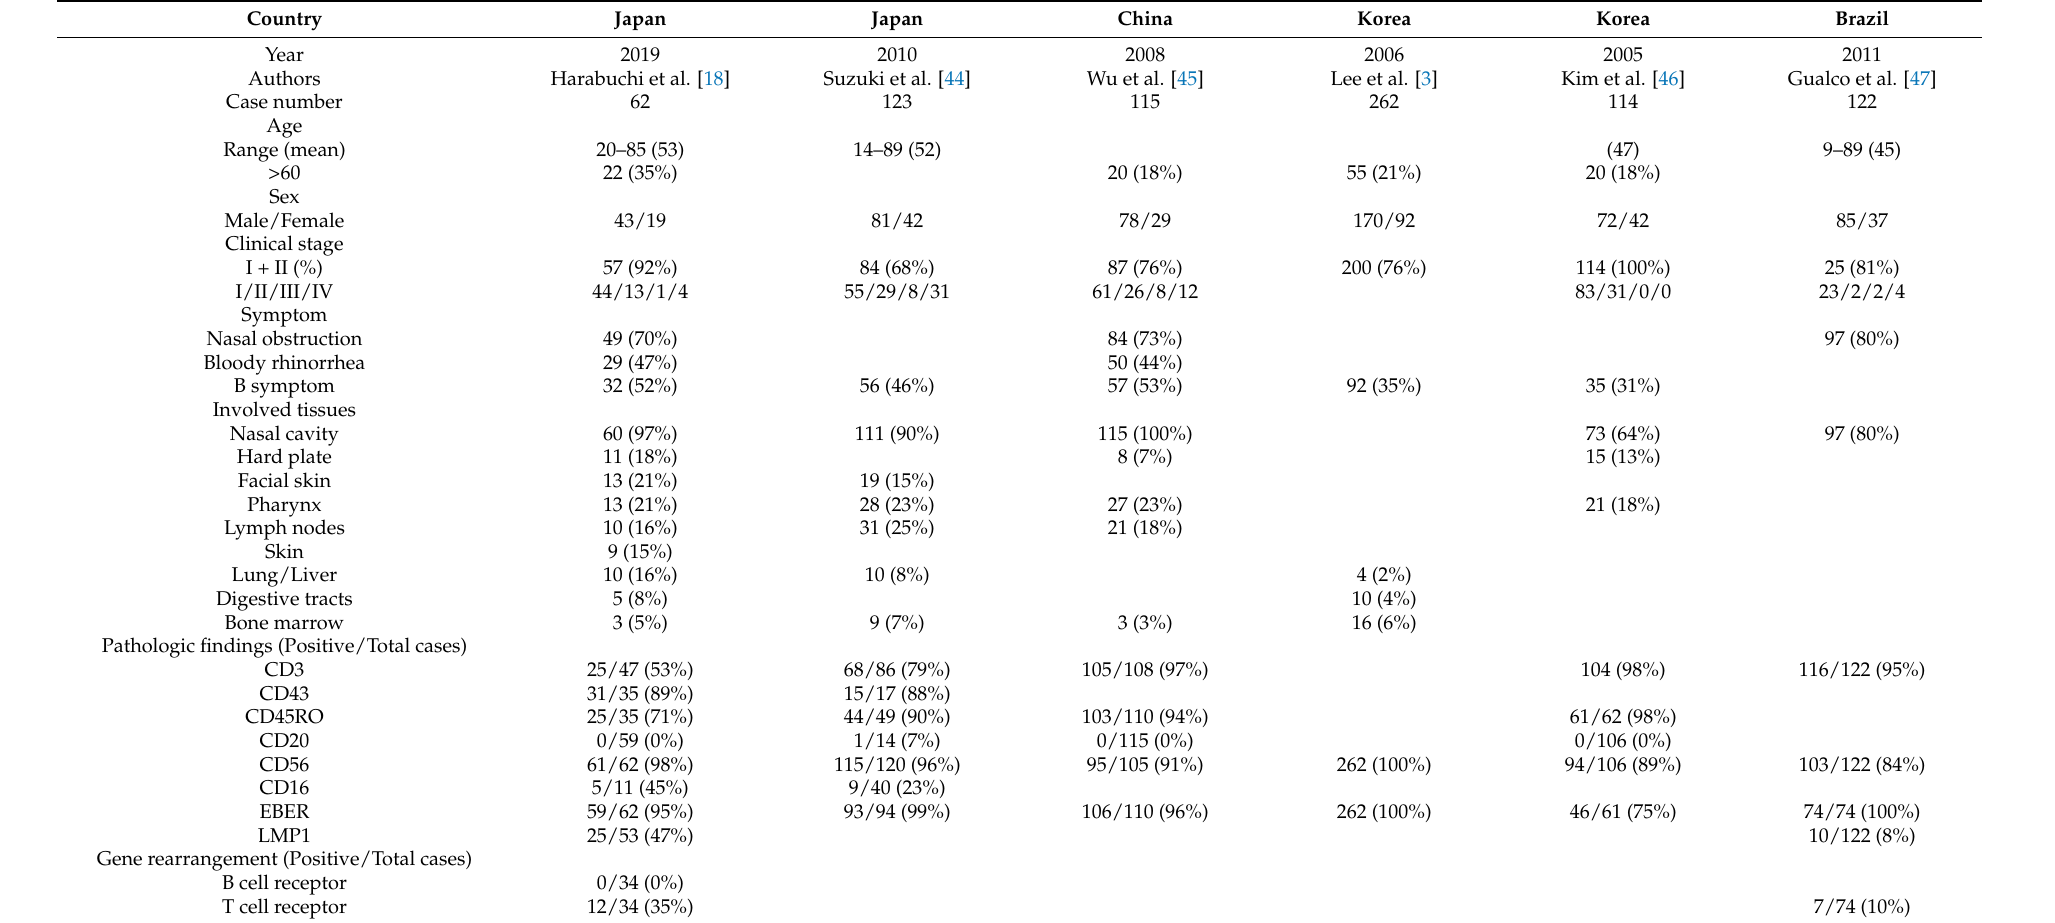
Table 1. Clinicopathological features of extranodal NK/T-Cell lymphoma, nasal